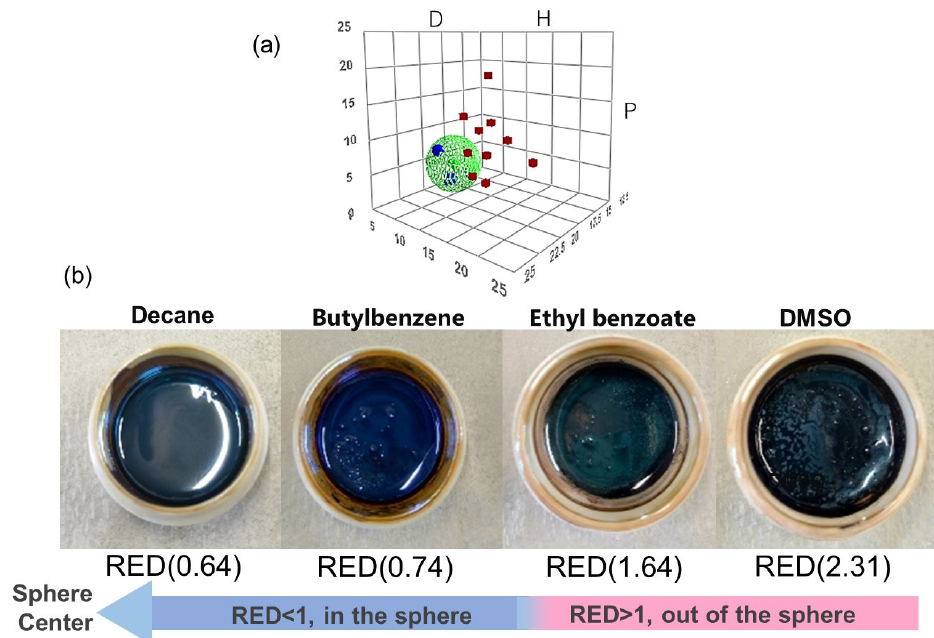
Figure 4. ( a ) HSP sphere of OAm-Ag NPs derived from the HSPiP software. The large green sphere indicates the dispersibility sphere of the OAm-Ag NPs, while the small green sphere in the middle represents the precise coordinates. The red cubes indicate the low-dispersibility-ranked solvents and the blue tetrahedrons indicate the high-dispersibility-ranked solvents and ( b ) OAm-Ag NP inks with decane (RED = 0.64), butylene (RED = 0.74), ethyl benzoate (RED = 1.64), and DMSO (RED = 2.31).